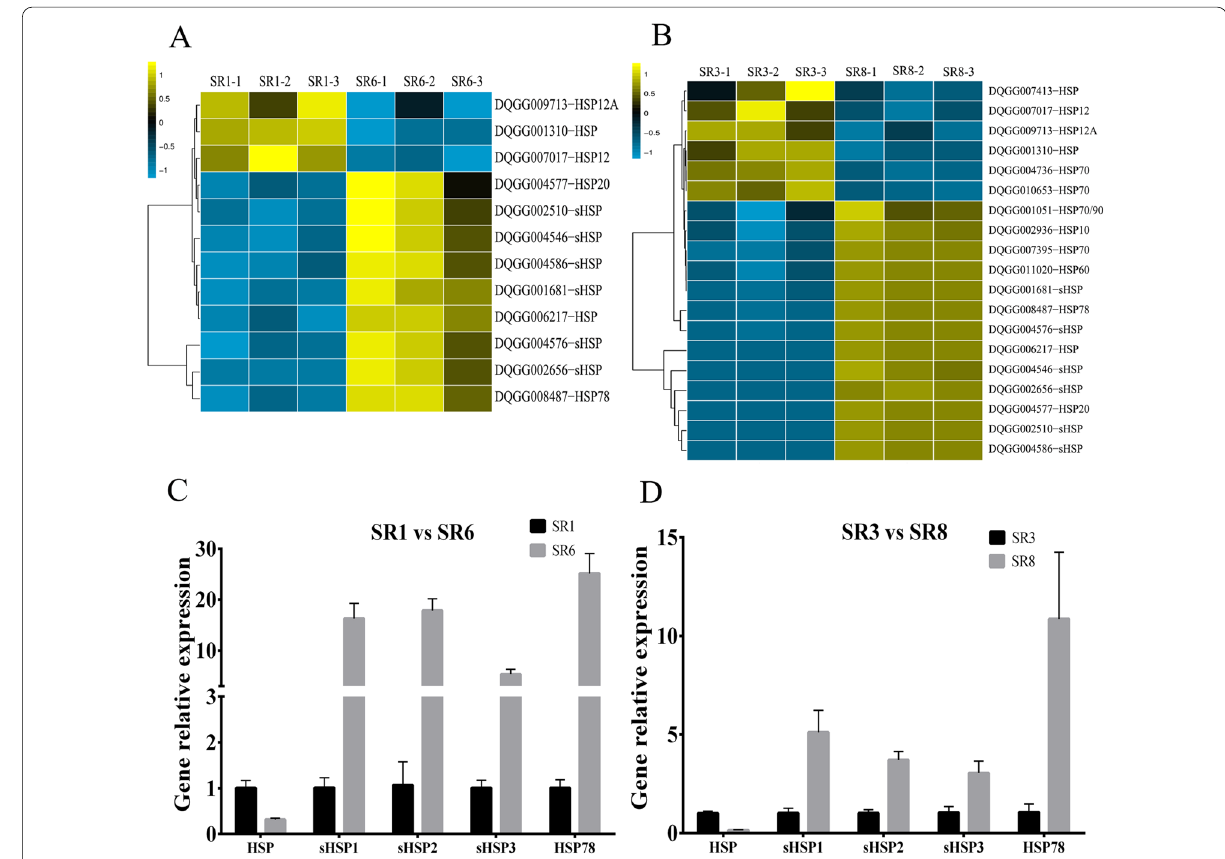
Fig. 7 Analysis of heat shock protein expression under the different temperature treatments. A and B Transcriptome comparative analysis of the expression of heat shock protein genes between different treatments. C and D Validation of the expression levels of five differentially expressed heat shock proteins (HSP, sHSP1, sHSP2, sHSP3 and HSP78). The error bars represent the means